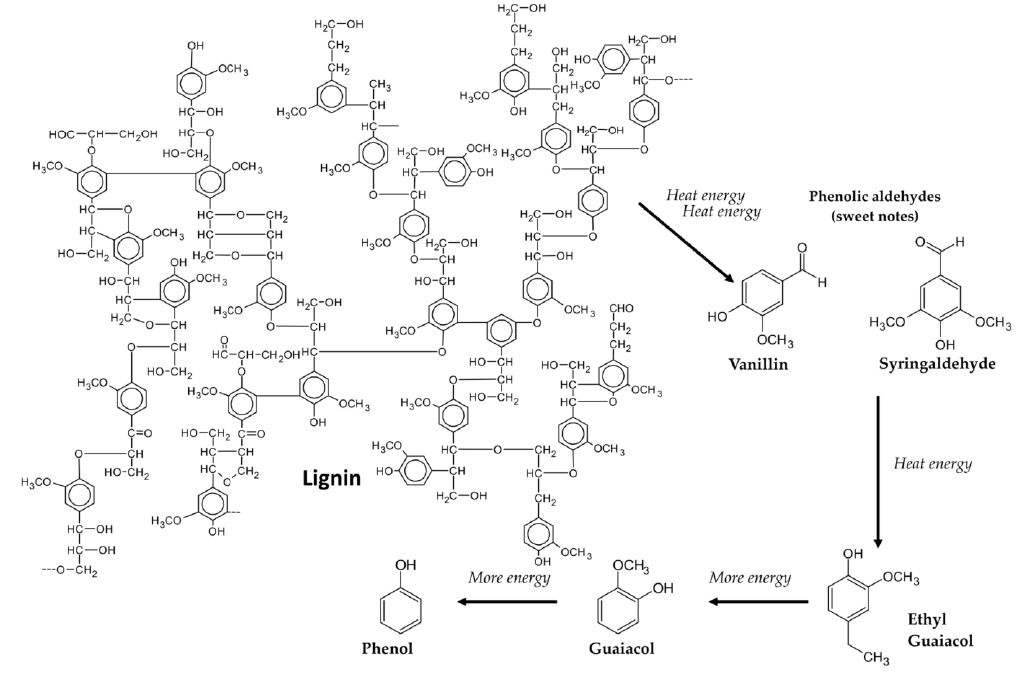
Molecules 2023 , 28 , 620 Figure 3. Thermal degradation of lignin [43]. Figure 3. Thermal degradation of lignin [43].